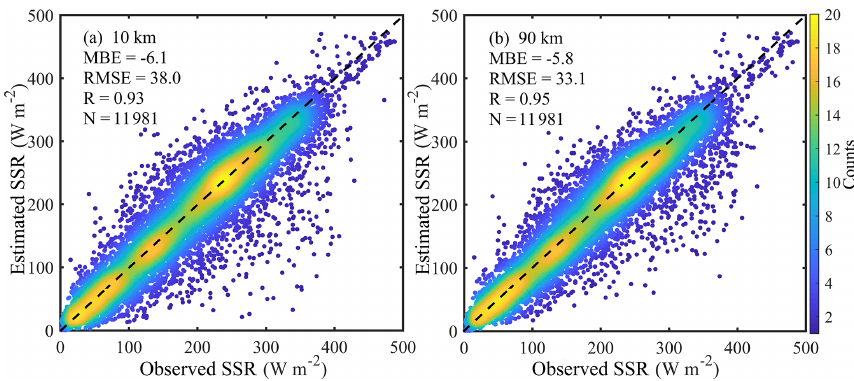
Figure 4. Comparisons of our estimated daily SSR at spatial resolutions of (a) 10km and (b) 90km with observed SSR for 42 BSRN stations.